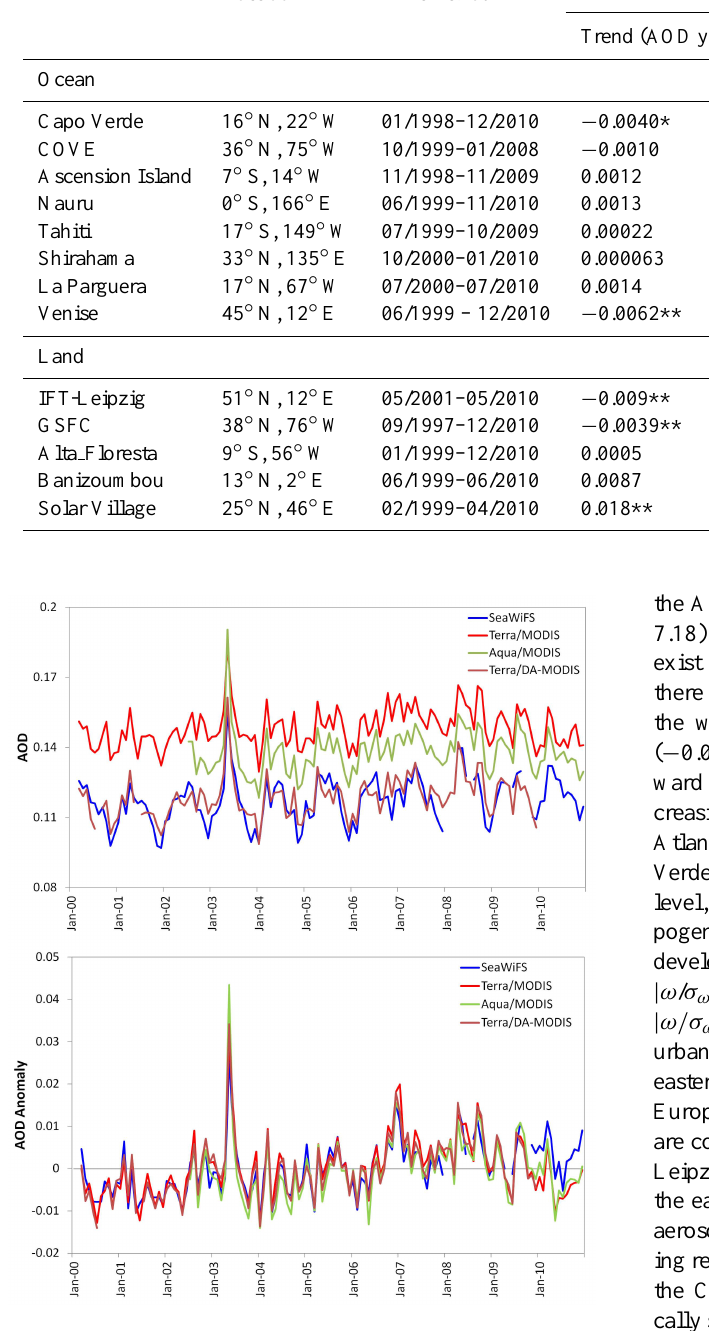
Fig. 7. Comparisons of the absolute AOD (top) and AOD anomaly (bottom) averaged over global ocean as a function of year between SeaWiFS and various MODIS products. The estimated linear trend is 0.00098yr − 1 for SeaWiFS and 0.00061yr − 1 for MODIS